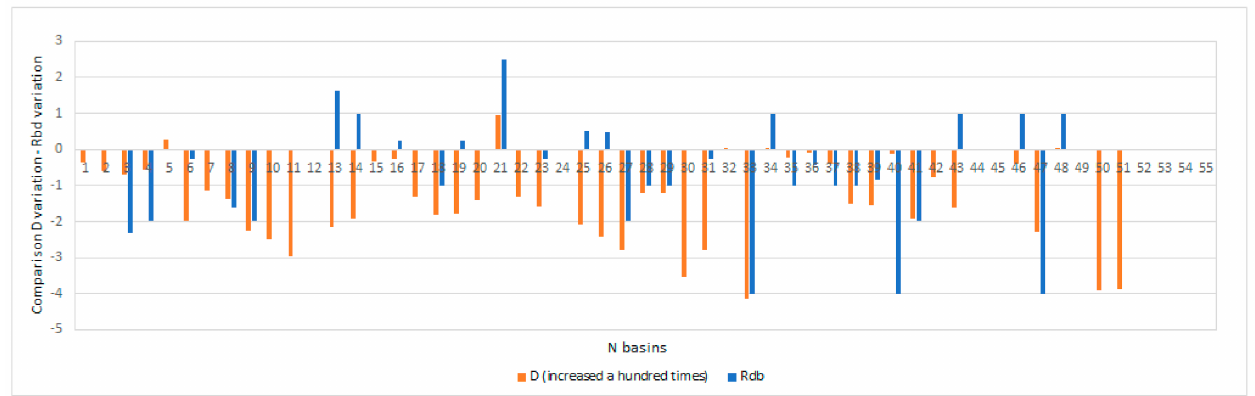
Figure 8. Comparison between D values in 1973 and D values in 2014 (increased a hundred times) (in orange) and differences between Rbd values in 1973 and Rbd values in 2014 (in blue) (y axis) and number of basins (x axis).